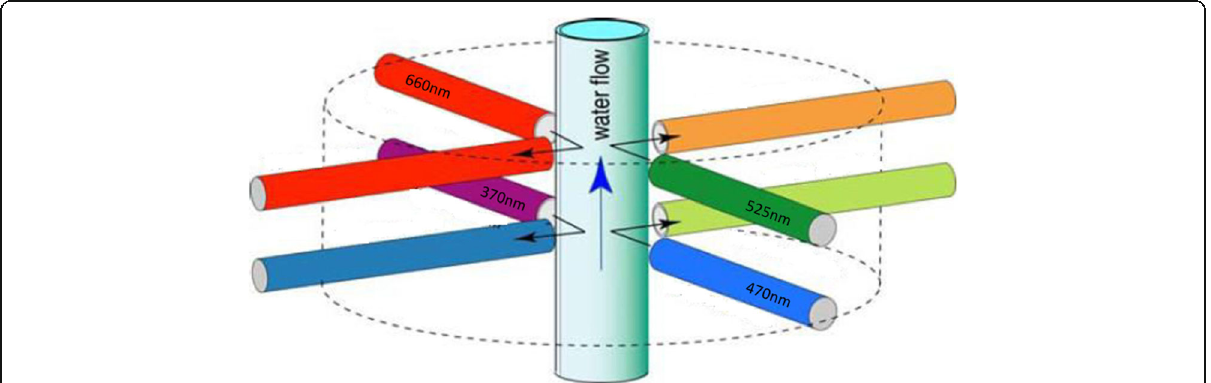
Fig. 1 Schematic functional sketch of the installed flow-through fluorometer of the type GUGN – FL30. The light sources with the specific wavelengths namely, 370 nm, 470 nm, 525 nm and 660 nm and corresponding detector ends are represented together with arrows perpendicular to the main water through flow tube (modified after Schnegg